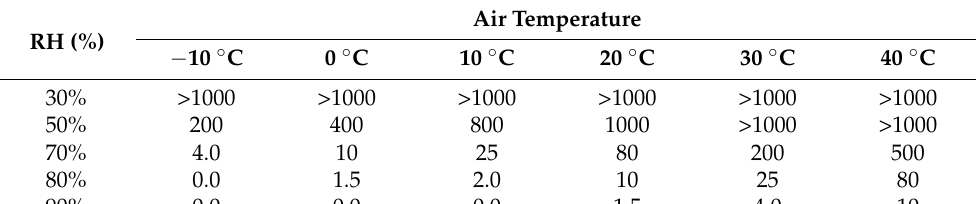
Table 3. Starting concentrations of HCl (ppmv) to form aerosol with respect to various air temperature and relative humidity [27].